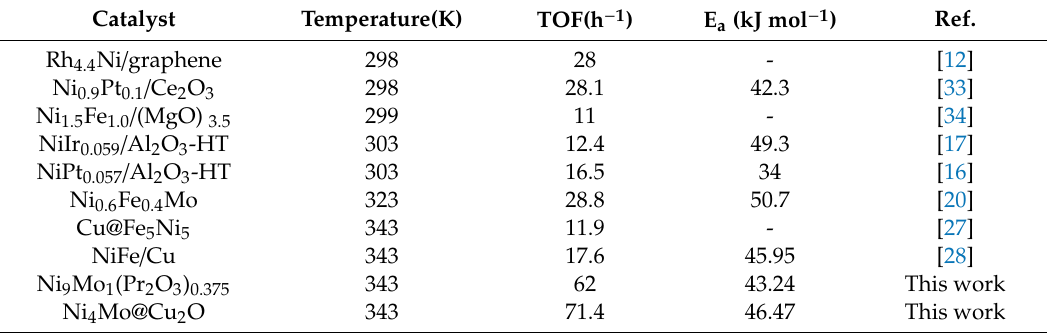
Figure 4. ( a ) Time-course profiles for the N 2 H 4 · H 2 O decomposition over the Ni 1-x Mo x catalysts; ( b ) catalytic performance tests of NiMo(Pr 2 O 3 ) with di ff erent molar ratios of NiMo and Pr; and ( c ) catalytic performance tests of NiMo@Cu 2 O with di ff erent molar ratios of NiMo and Cu. All the Table 1. Catalytic activity of di ff erent catalysts in hydrazine